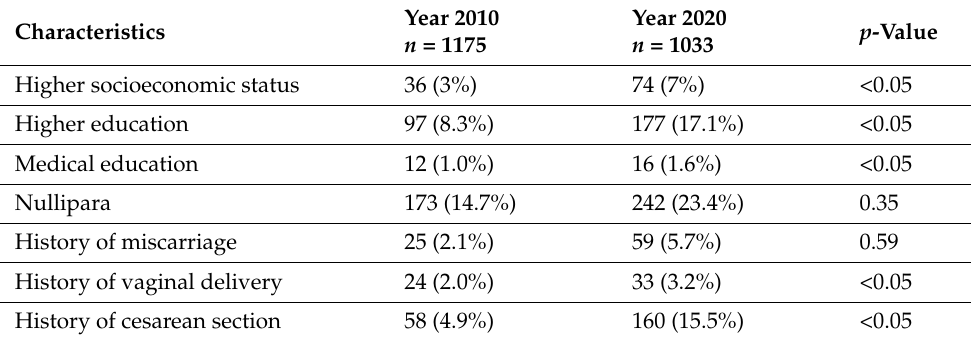
Table 2. Characteristics of women with preferred CS as way of